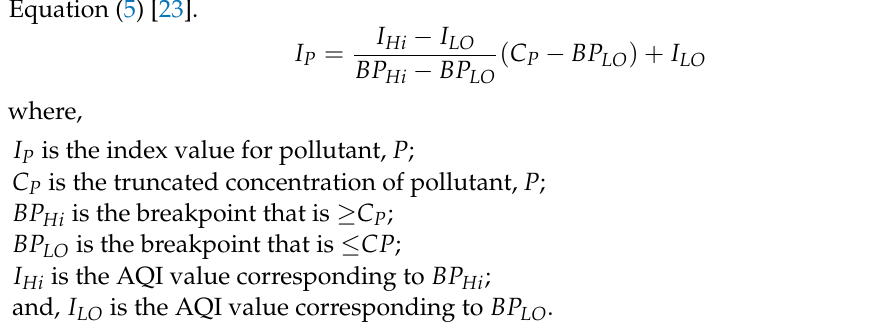
Red Purple Very Unhealthy 201 to 300 Maroon Hazardous 301 and